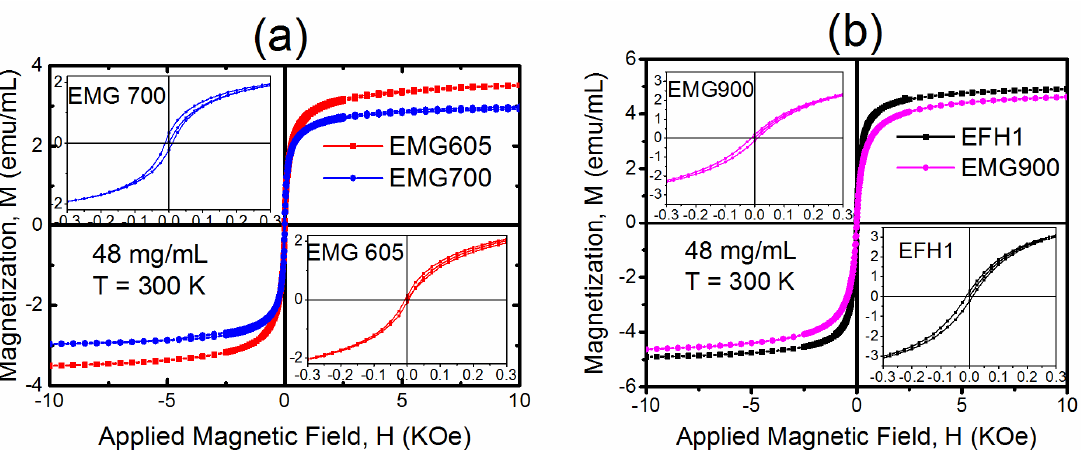
Figure 2. DC magnetization behavior of ( a ) water-based EMG 605 and EMG 700 samples, and ( b ) isopar − M − based EMG 900 and EFH1 samples, the inset shows the corresponding low field portion of the data.